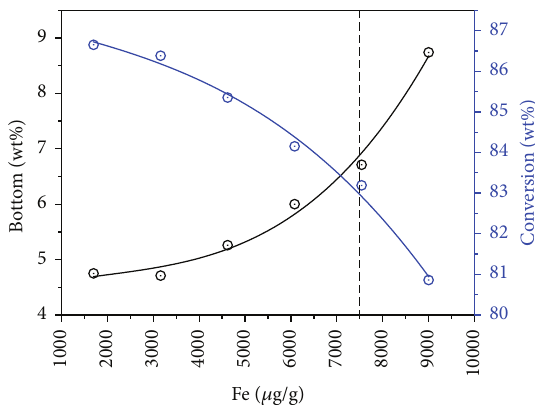
Figure 3: Alteration curves of catalyst’s conversion rate and heavy oil yield correlated with catalyst iron poisoning